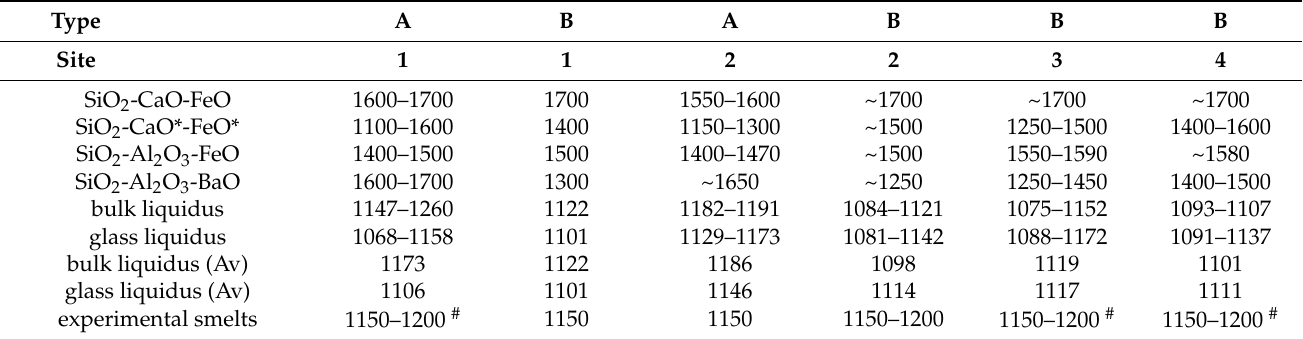
Table 7. Estimation of smelting temperatures ( ◦ C) for individual slag types and sites based on ternary diagrams, liquidus calculations and experimental smelts. The glass liquidus is derived from average values for samples. Av—average value, # —maximum temperature did not result in